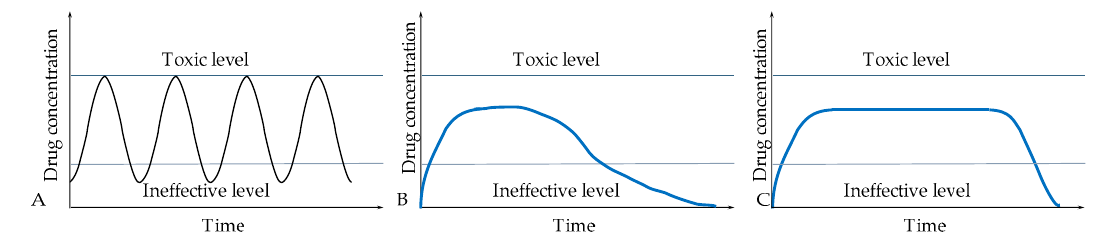
Figure 1. Possibilities of active substance release: ( A ) immediate release of active substance, ( B ) prolonged release of active substance, and ( C ) controlled release of active substance.